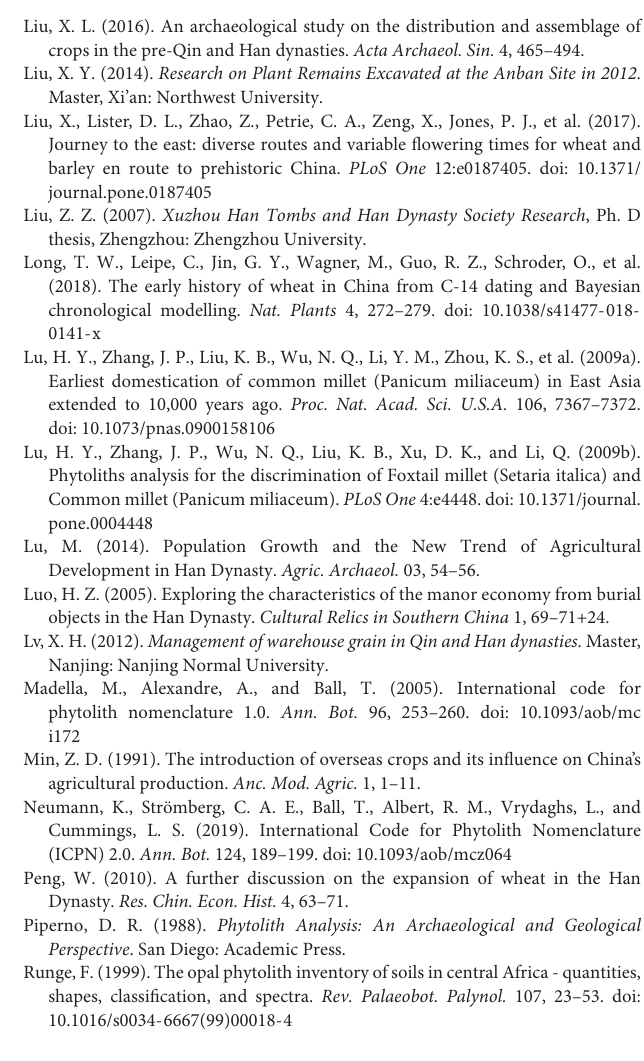
Supplementary Table 1 | Macro-botanical and isotopic